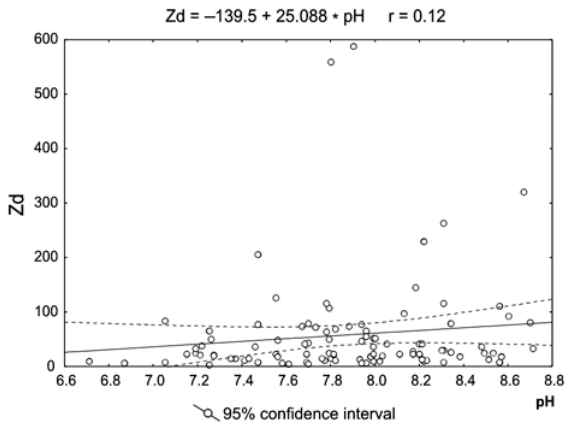
Fig. 7. Correlation ( r ) between the index of overall contamination (z ) and topsoil pH value in eldership of d Šnipiškės of the city